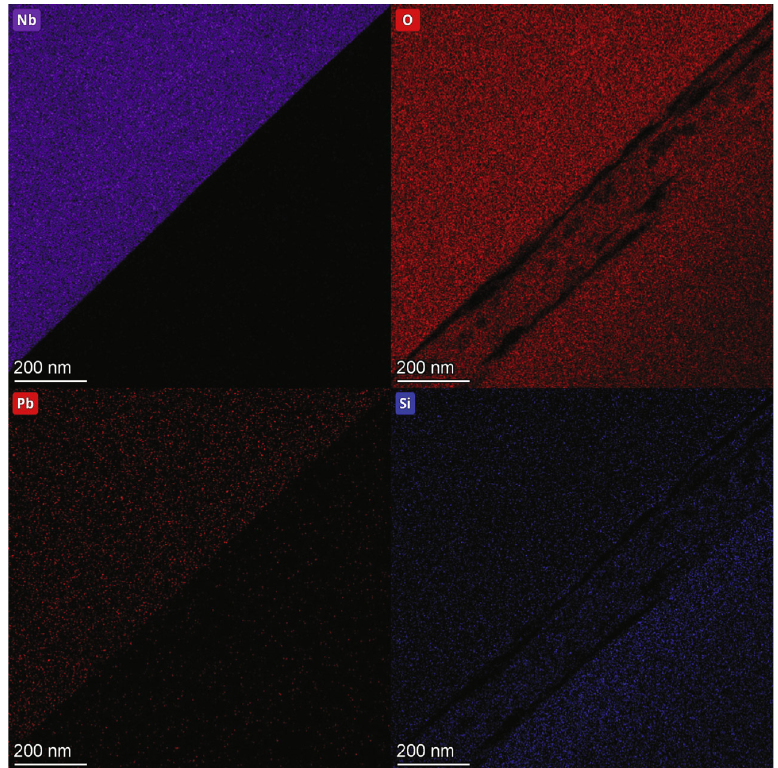
Figure 8: Nb, O, Pb, and Si maps of a FIB-cut of the columbite-tantalite mineral. The location of this FIB-cut is the same as in Figure 6.